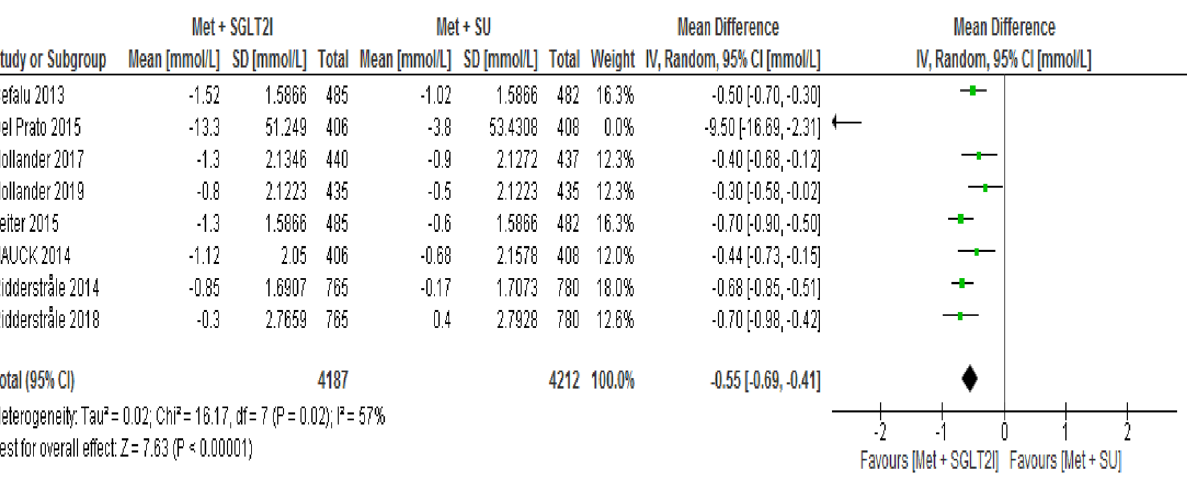
Figure 11. Comparison of change in FPG (mmol/L) from baseline between patients who were on metformin- SGIT2I and metformin-sulphonylureas combination therapies. SD standard deviation; CI confidence interval; MD mean difference; Met metformin; SGLT2I sodium-glucose co-transporter 2 inhibitor; SU